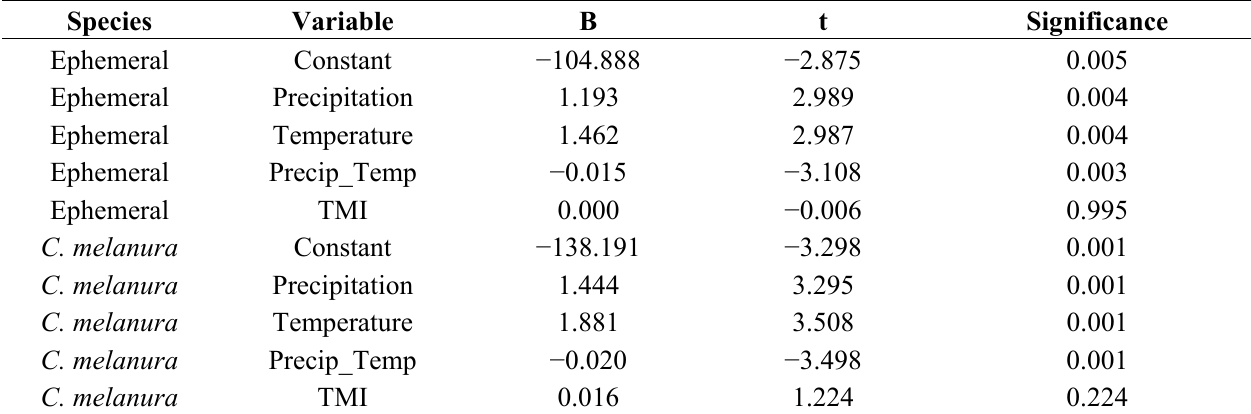
Table 5. Results of the EEV linear regression